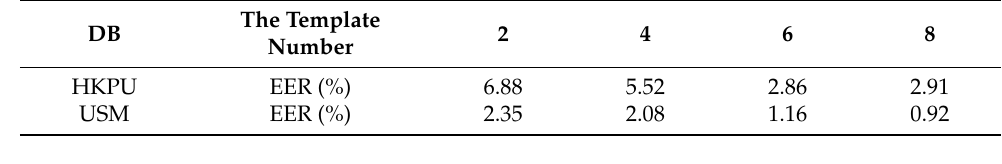
Table 2. The recognition performance under different number of templates.